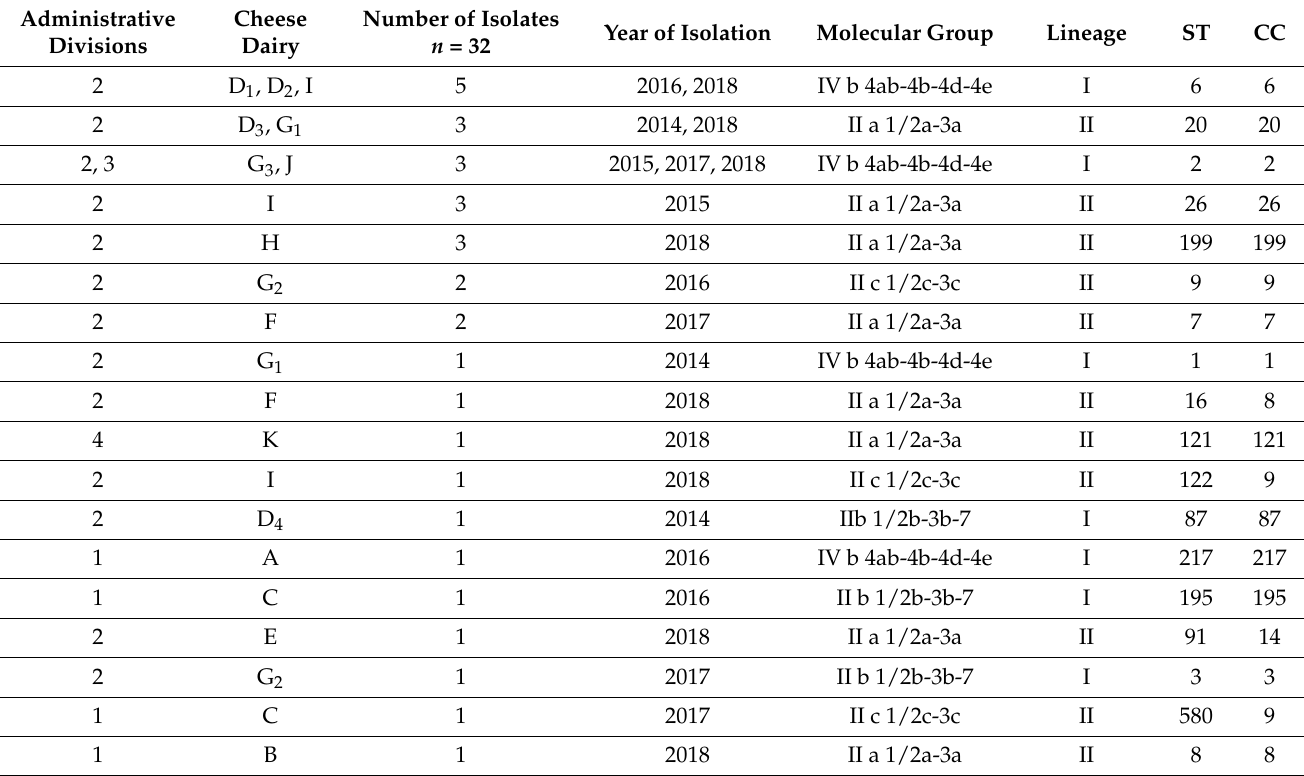
Table 1. Distribution (administrative divisions and cheese dairies), numbers, molecular groups, lineages, allelic profiles (ST), clonal complexes (CC) of the L. monocytogenes